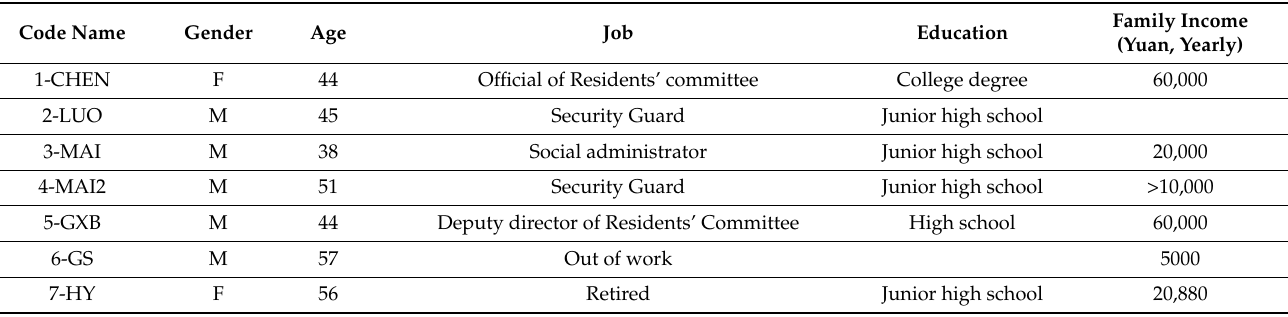
Table 1. Interviewees’ information.